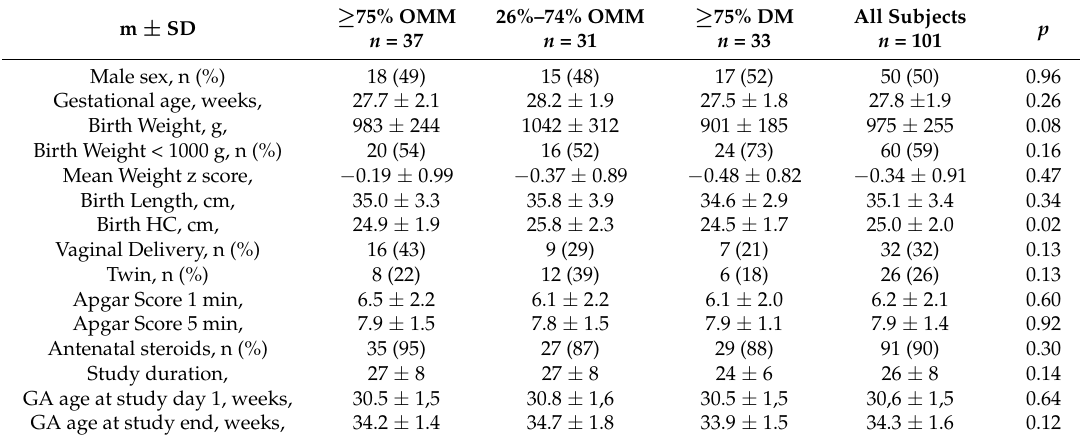
Table 1. Infants clinical characteristics according to human milk diet.